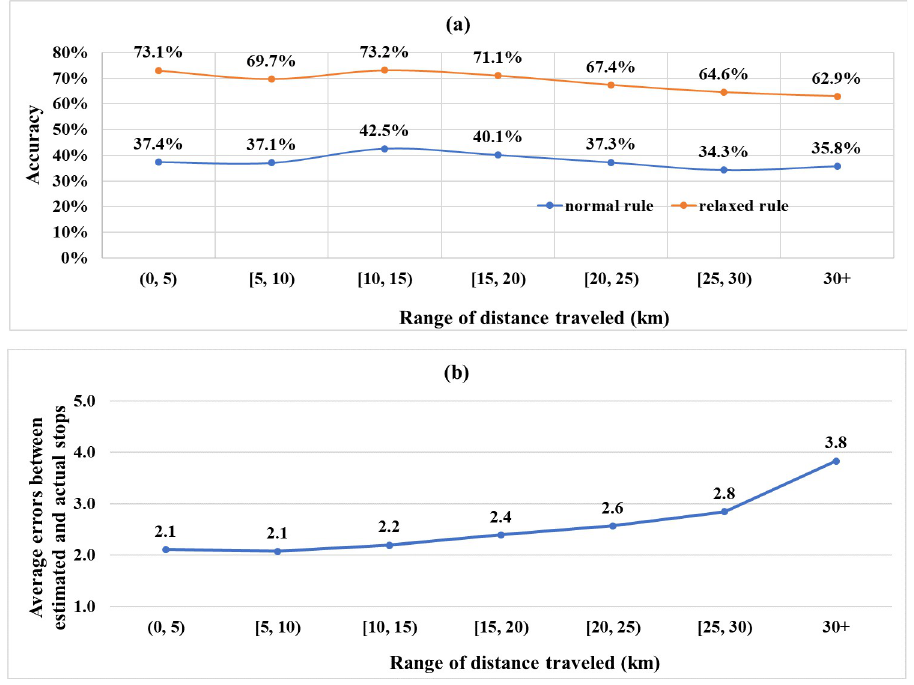
Fig 12. Estimation results according to the distance traveled (a. estimation accuracy, b. estimation error).